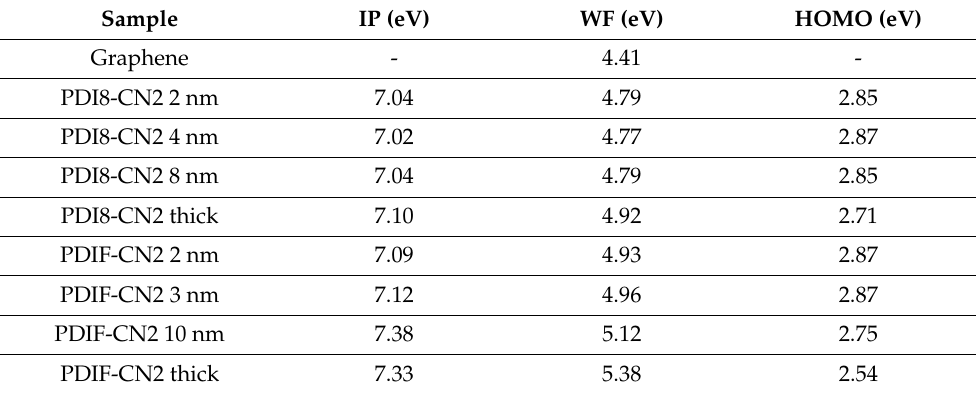
Table 2. Summary of the IP, HOMO, and WF values (from the UPS analysis) referred to in the PDI8-CN2 and PDIF-CN2 thin films with different nominal thicknesses. Values for the thick films and bare graphene are shown for